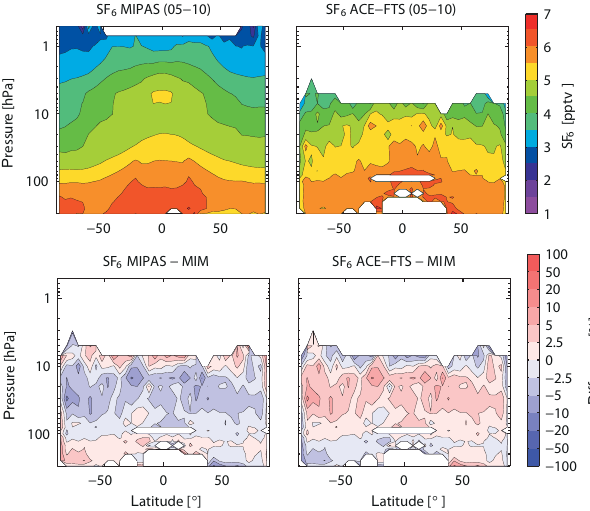
Figure 10. Altitude–latitude cross sections of annual zonal mean SF 6 (upper panels) for MIPAS and ACE-FTS and relative differ- ences between the individual instruments and the MIM (lower pan- els) are shown for 2005–2010.